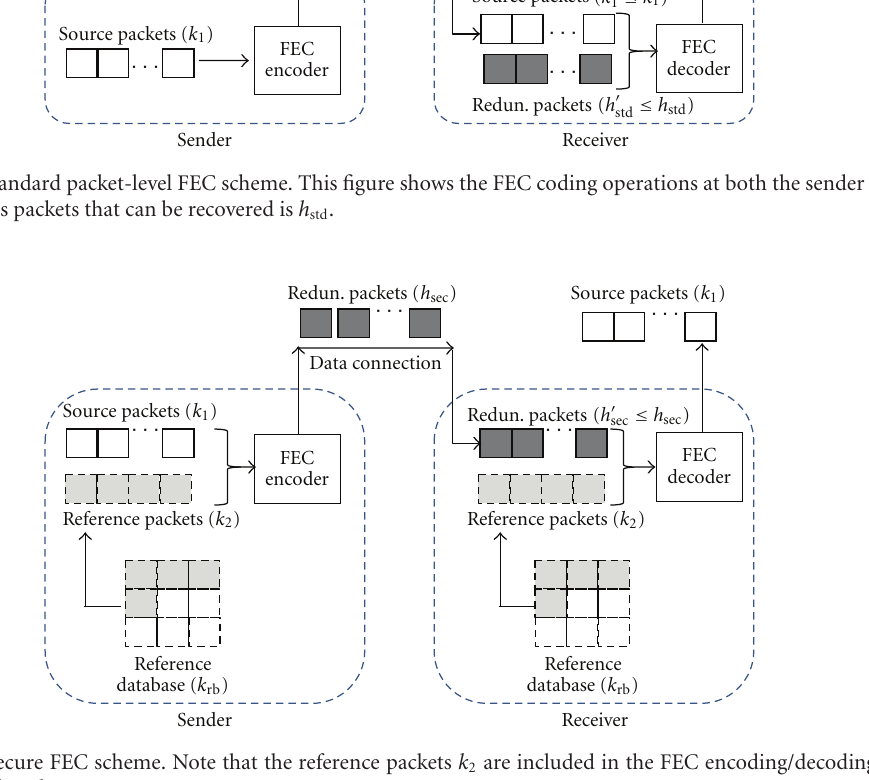
Figure 2: Overview of secure FEC scheme. Note that the reference packets k 2 are included in the FEC encoding/decoding, and the sender transmits redundant packets h sec